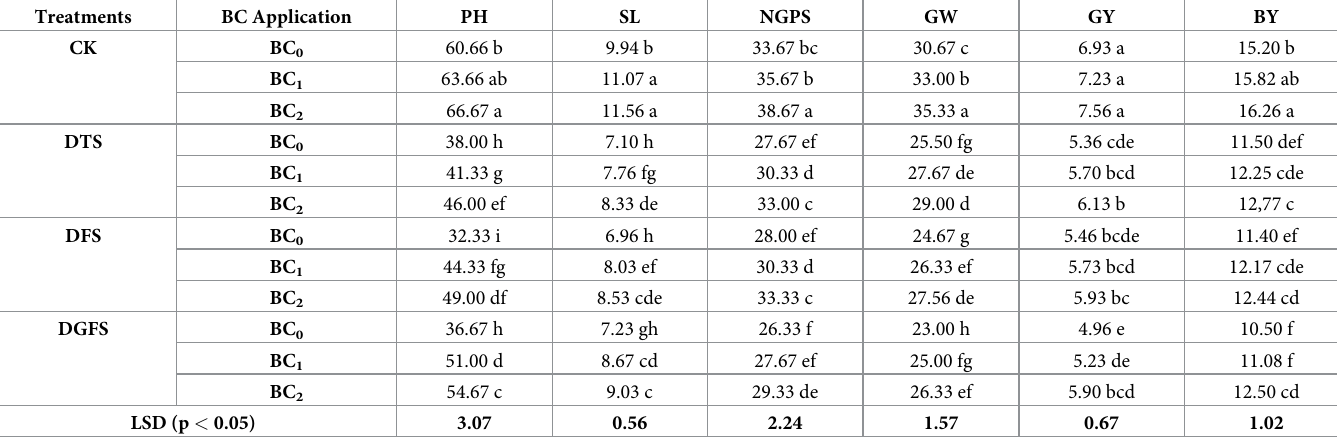
Table 2. The effect of biochar on plant height (PH, cm), spike length (SL, cm), number of grains per spike (NGPS), 1000-grain weight (GW, g), grain yield (GY, g pot -1 ), biological yield (BY, g pot -1 ), harvest index (HI) of wheat under drought stress. Treatments